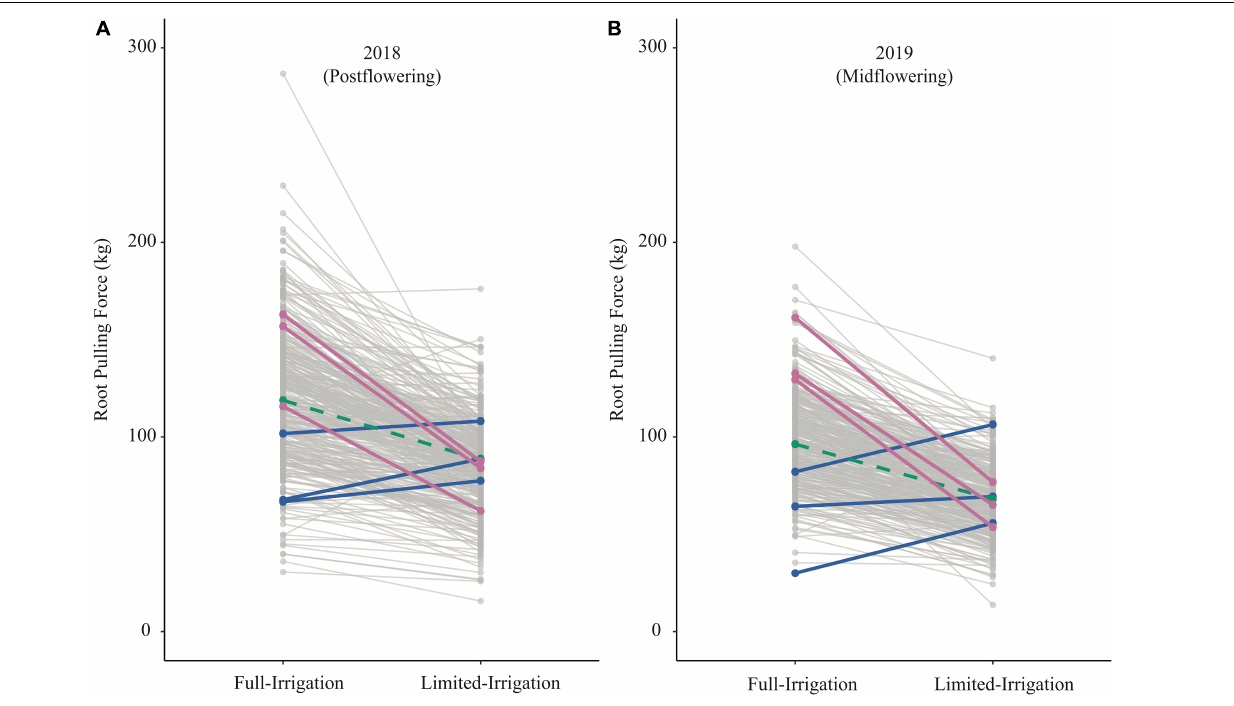
FIGURE 6 | Reaction norms for RPF across irrigation treatments in 2018 (A) and 2019 (B) . Blue lines highlight three genotypes (I205, H91, and S8324) that consistently increased RPF under LI; Pink shows three genotypes (A661, 207, and PHN11) where RPF decreased strongly in both years under LI; Green indicates genotype 793, which was approximately average for response to